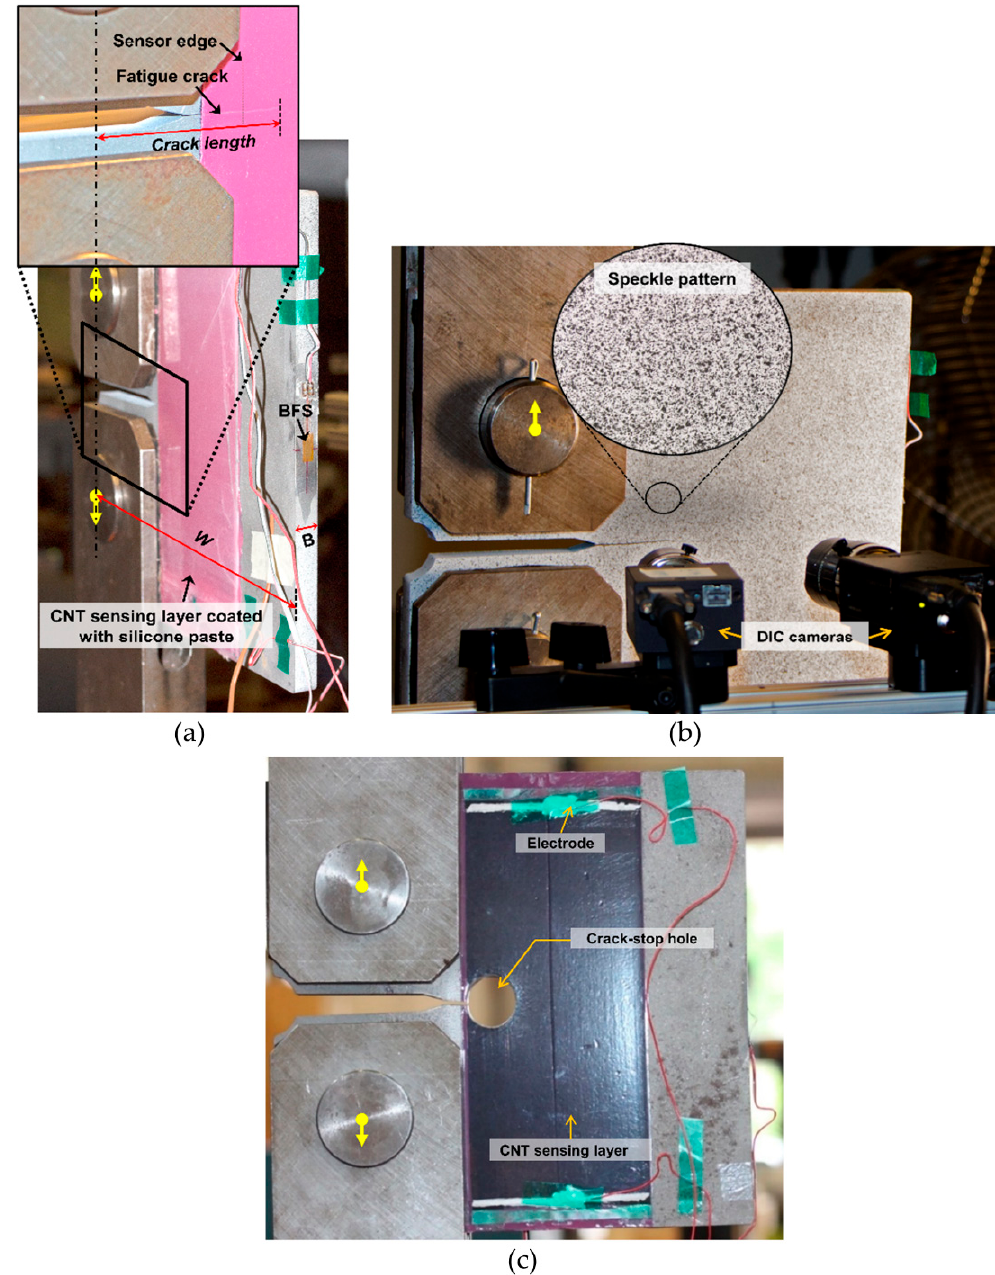
Figure 4. Test setup with ASTM E647 contact tension (CT) specimen instrumented with CNT sensor and back-face strain (BFS) gage: ( a ) fatigue-cracked specimen with inset showing fatigue crack and crack length measurement, ( b ) three-dimensional digital image correlation (3D-DIC) setup for the potential false positive evaluation test specimens, and ( c ) crack-stop hole test specimen to examine fatigue crack re-initiation (shown without protective outer adhesive and silicone layers). Yellow arrows in ( a ), ( b ), and ( c ) show load application points.